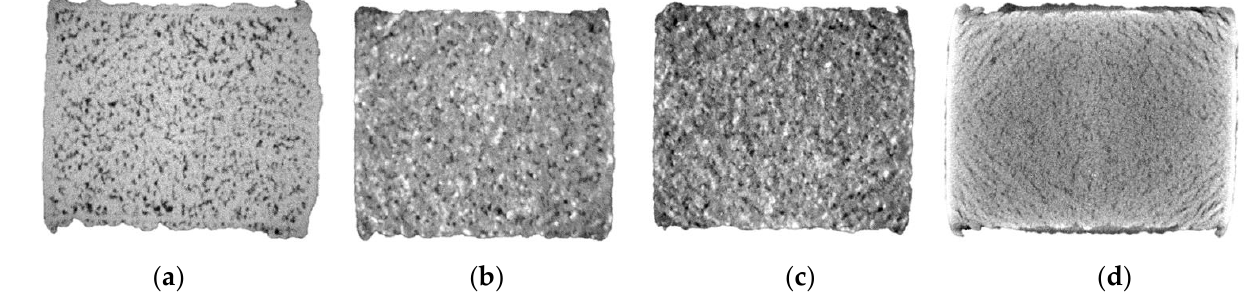
Figure 6. Computed Tomography data for high-purity Cu, Ag and Cu – Ag alloys, where ( a ) is EOS Cu, ( b ) is Cu – Ag10%, ( c ) is Cu – Ag20% and ( d ) is Legor Ag.